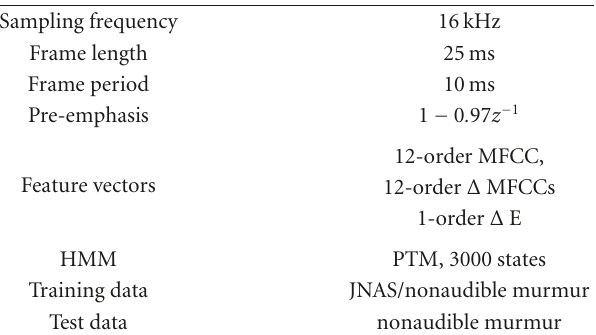
Table 1: System specifications.